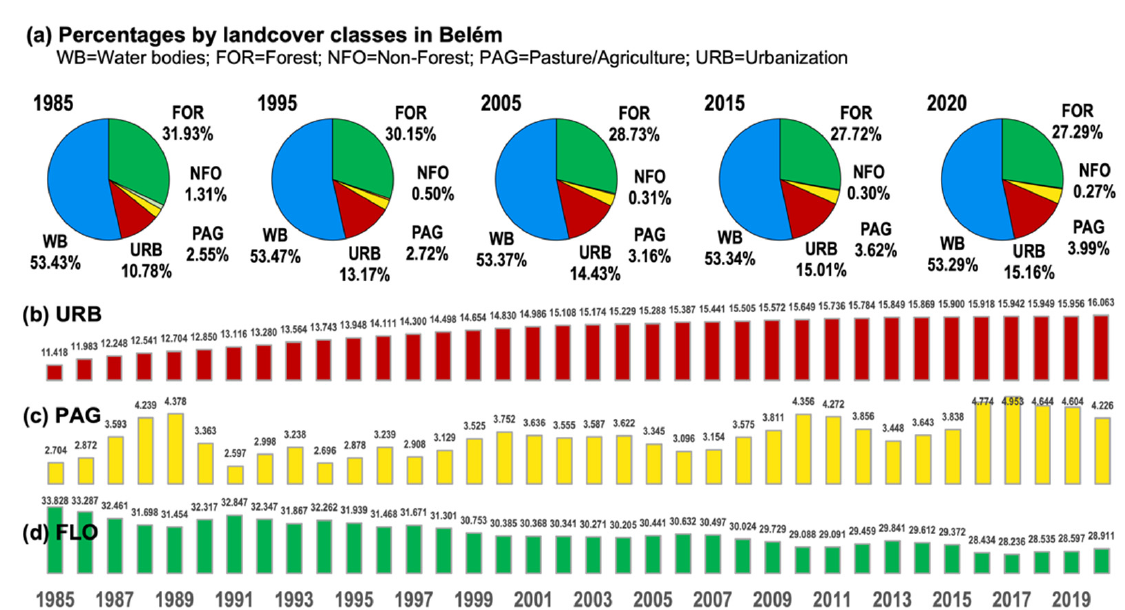
Figure A1. Results for Belém, ( a ) percentages by landcover classes; ( b ) URB urbanization; ( c ) PAG pasture/agriculture; and ( d ) URB urbanization. Results for a are shown in the years 1985, 1995, 2005, 2015, and 2020. The annual series for ( b – d ) are in area (ha) from 1985 to 2020. Table A3. Differences between the means of future (2021/20245) and present (1985/2020) for TEMP and PREC in the RAINY and DRY for Belém and MRB, and the p -value obtained in Student’s t -test.